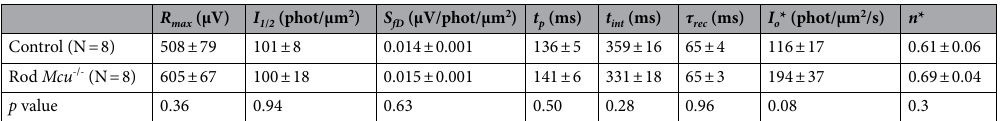
Table 1. Dim flash response sensitivity and kinetics parameters. R max saturated response amplitude measured at the plateau, I 1/2 intensity required to produce half of the saturated response, S fD dark adapted sensitivity, t p time to peak of a dim flash response, t int integration time of the response, τ rec recovery time constant during response shut off, I o intensity required to decay the sensitivity to one half.